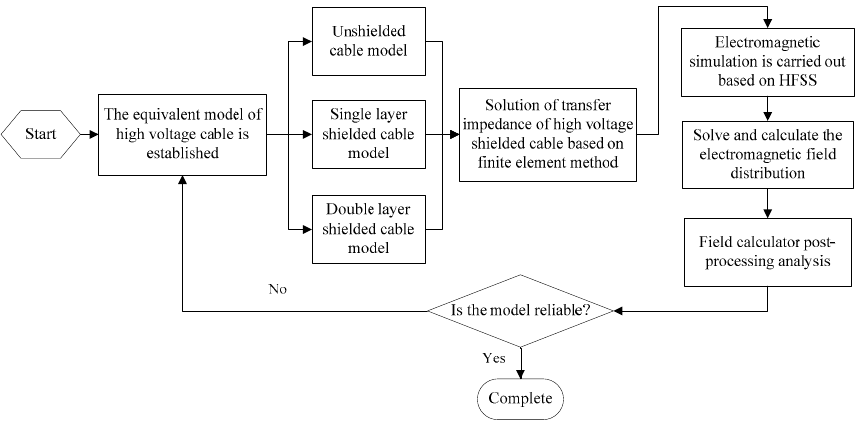
Figure 5. Modeling methods for high voltage without shielded and shielded cables.